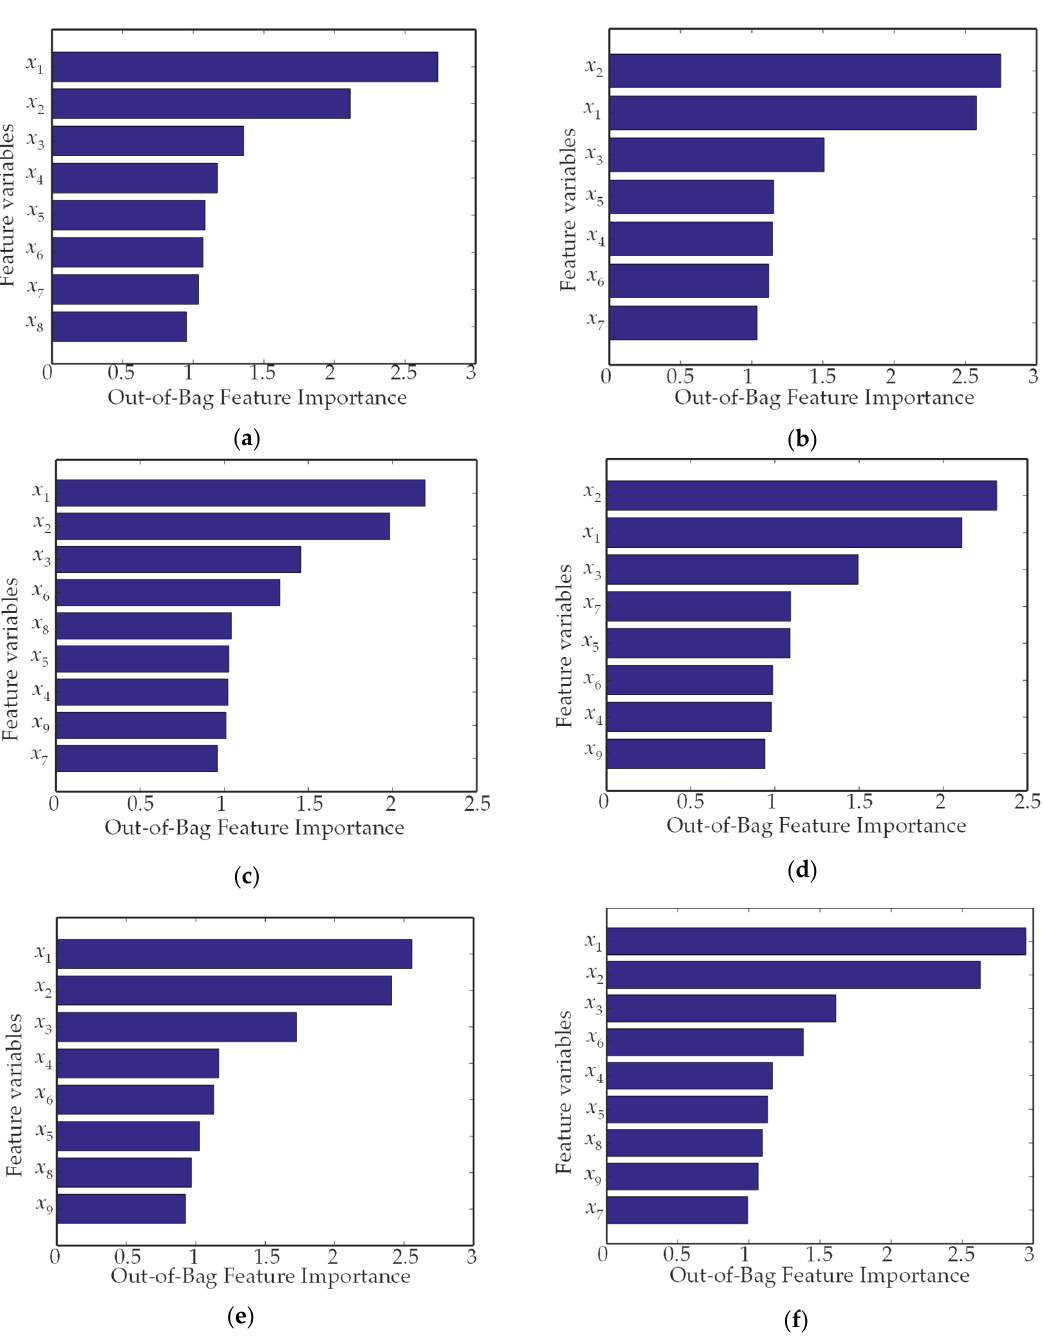
Figure 5. RF variable importance contrast: ( a ) Data 1; ( b ) Data 2; ( c ) Data 3; ( d ) Data 4; ( e ) Data 5; and ( f ) Full Data. x 1 denotes days after the last rain; x 2 denotes daily average relative humidity; x 3 denotes daily maximum temperature; x 4 denotes daily minimum relative humidity; x 5 denotes daily average temperature; x 6 denotes daily precipitation; x 7 denotes distance to settlement; x 8 denotes daily minimum temperature; x 9 denotes daily average water vapor pressure.